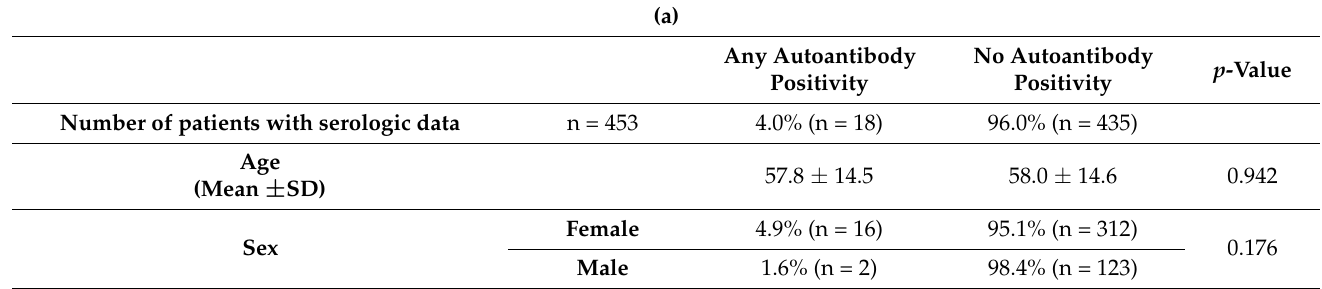
Table 2. a: Comparison between autoantibody-positive AIIRD patients to AIIRD patients without au- toantibody production following second vaccine dose. b: Comparison between autoantibody-positive AIIRD patients to AIIRD patients without autoantibody production following third vaccine dose. (a) Any Autoantibody No Autoantibody p -Value Positivity Positivity Number of patients with serologic